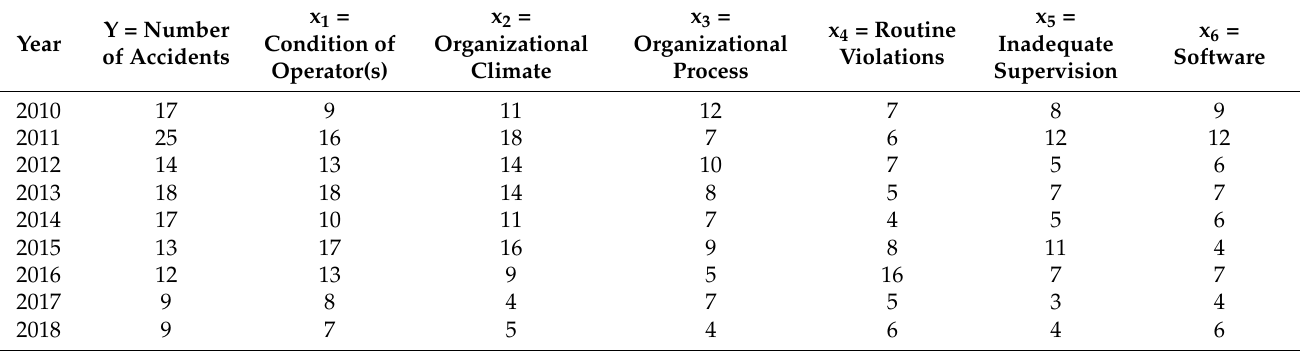
Table 3. Distribution of most frequent causal factors categories by years.